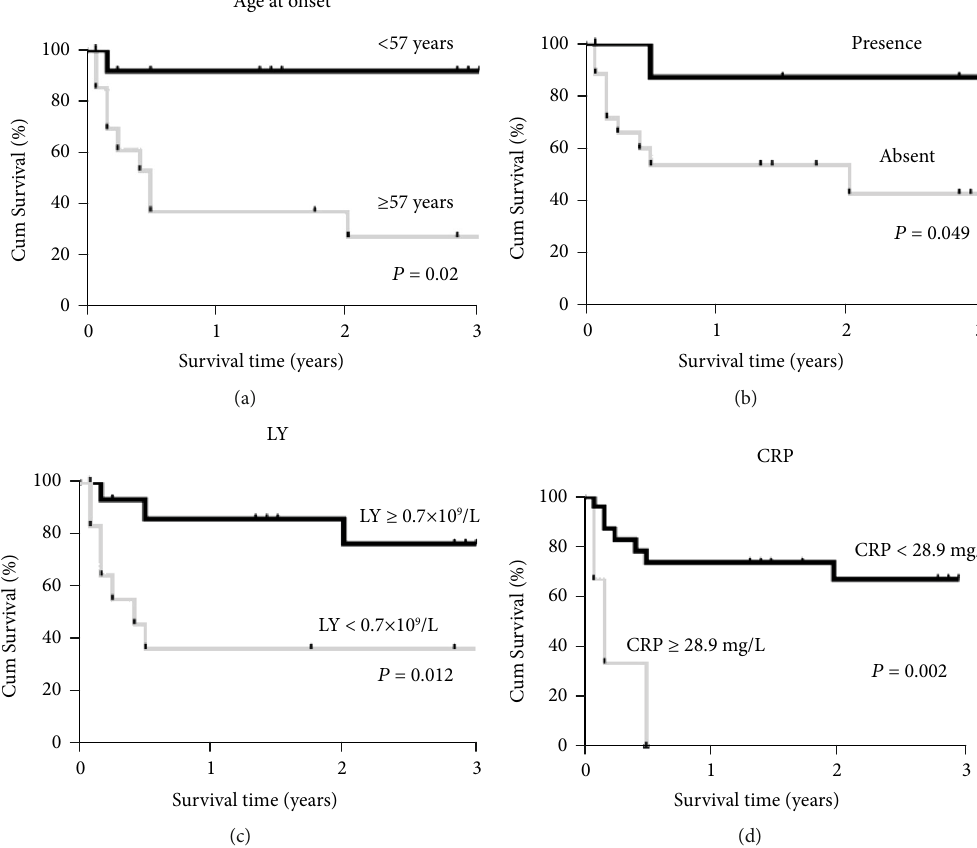
Figure 2: Survival rates between groups strati fi ed by initial predictors of anti-MDA5-associated RP-ILD mortality. Kaplan-Meier survival curves for anti-MDA5-associated RP-ILD: (a) ageat onset ≥ 57 years and < 57years; (b) periungual erythema presence versus absent; (c) lymphocyte count ≥ 0 : 7 × 10 9 /L and <0 : 7 × 10 9 /L ; (d) CRP ≥ 28 : 9 mg/L and < 28.9mg/L. RP-ILD: rapidly progressive interstitial lung disease; MDA5: melanoma di ff erentiation-associated gene 5; DM: